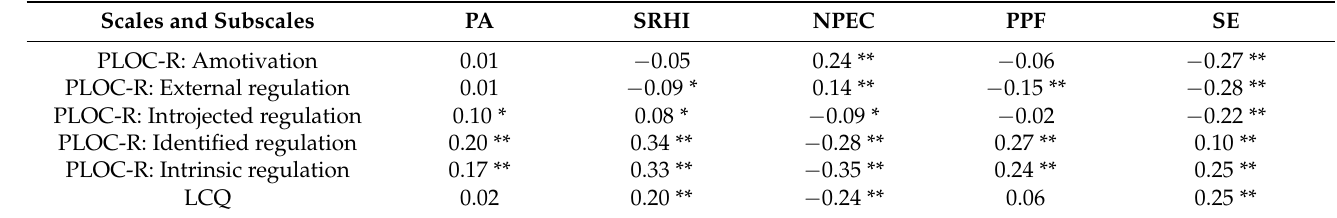
Table 3. Correlations between the Revised Perceived Locus of Causality in Physical Education Scale (PLOC-R) subscales, Learning Climate Questionnaire (LCQ), physical activity-related behaviours and